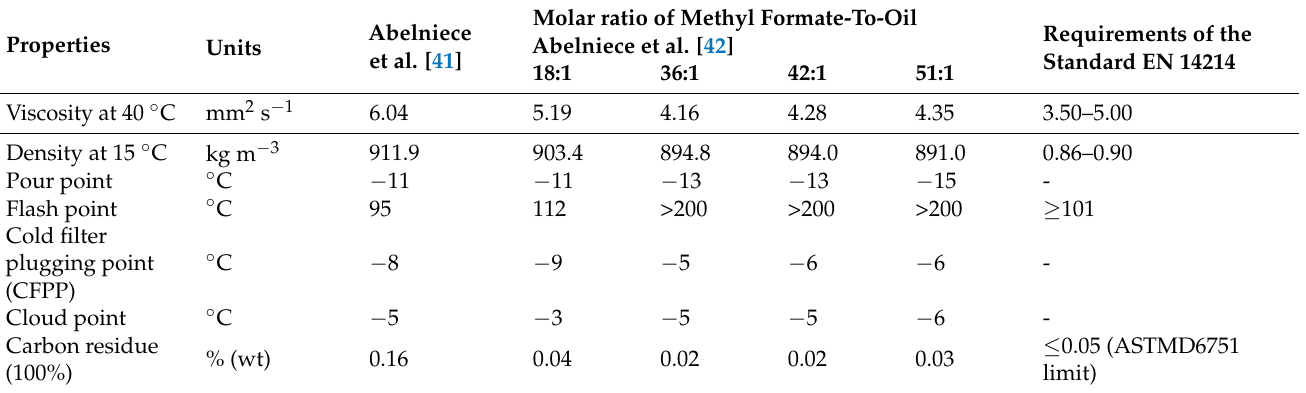
Table 3. Properties of products obtained by interesterifying with methyl